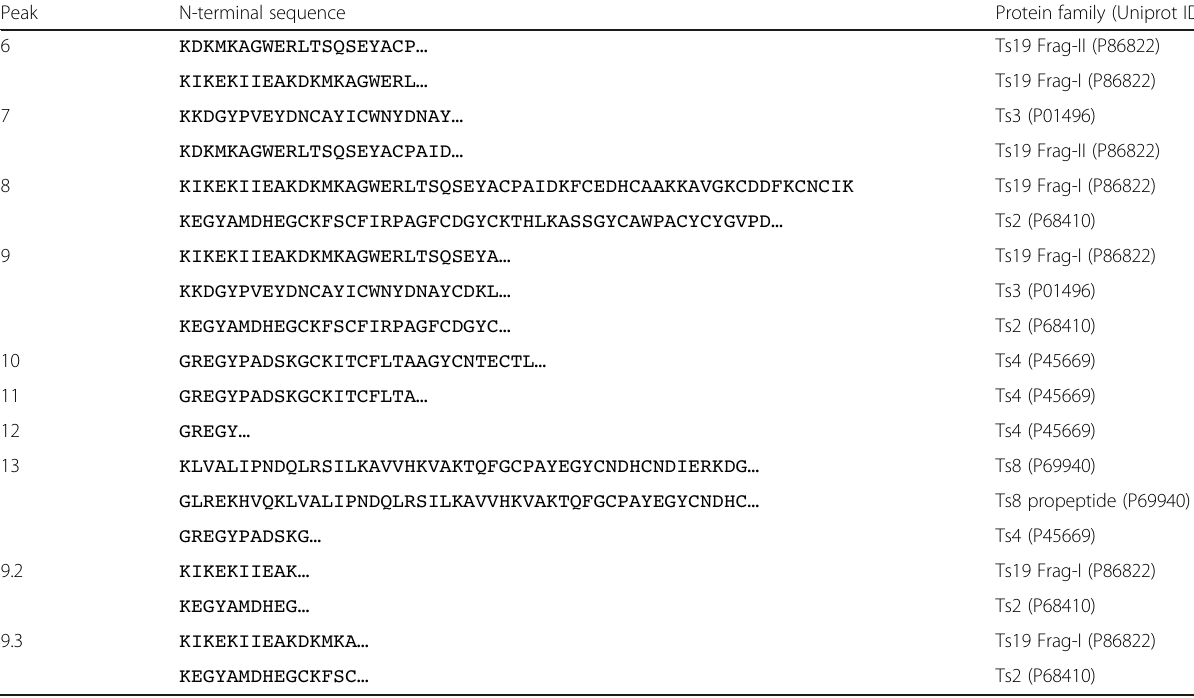
Table 1 N-terminal sequence of the main peaks eluted from the chromatographic steps. Assignment of the peaks to protein families by BLAST against a Tityus venom database